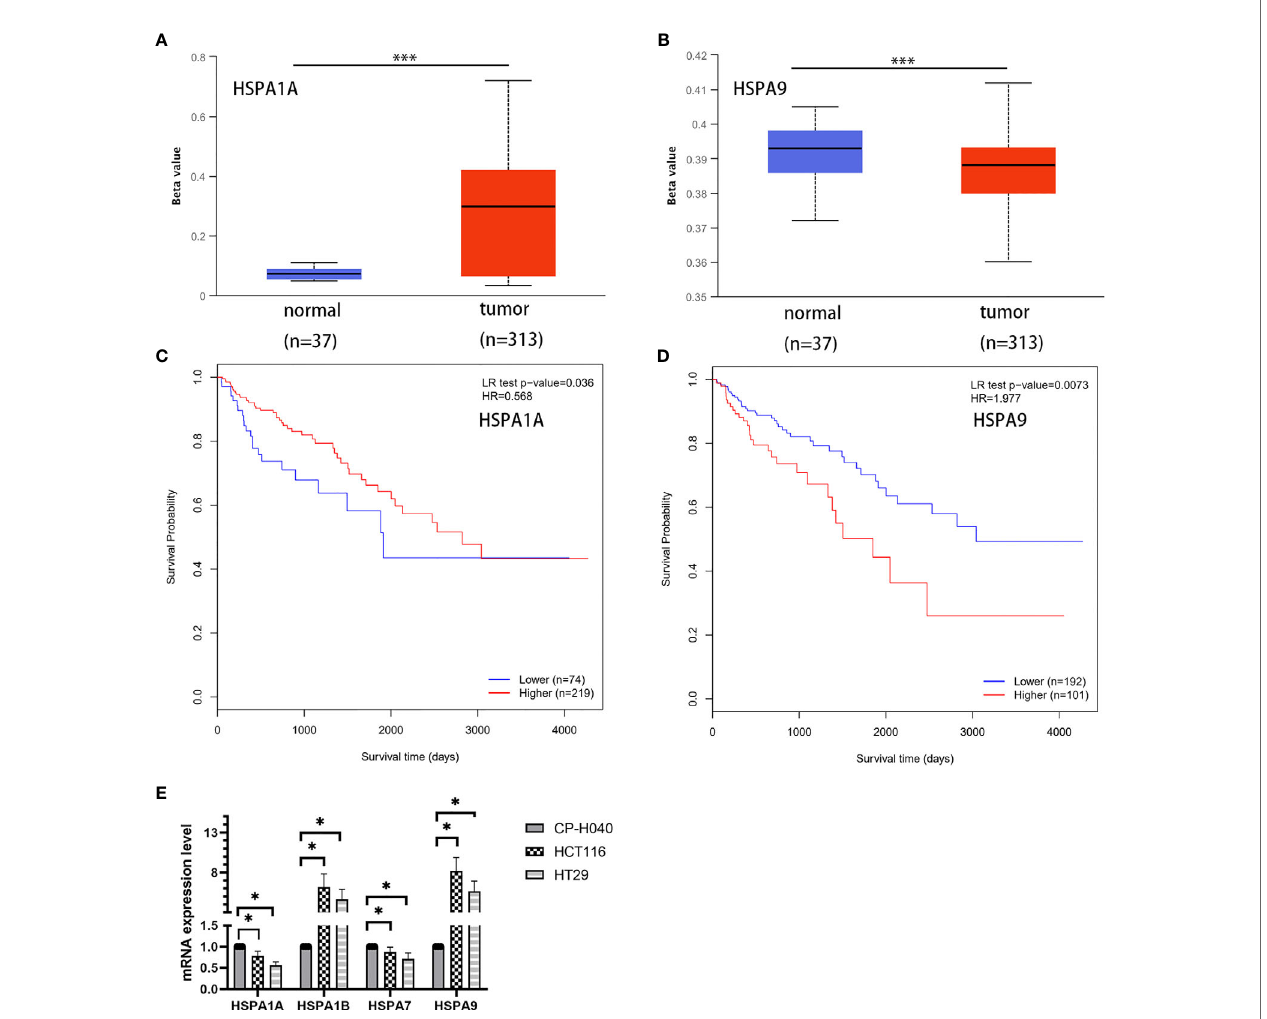
FIGURE 5 | Analysis of DNA methylation of HSPA1A and HSPA9 genes in normal and colon cancer tissues and the correlation with survival. (A) Methylation of HSPA1A promoter in colon cancer tissues and normal tissues. (B) Methylation of HSPA9 promoter in colon cancer tissues and normal tissues (*** P < 0.001). (C) Survival of patients with high and low HSPA1A promoter methylation level. (D) Survival of patients with high and low HSPA9 promoter methylation level. (E) Expression of HSPA1A/HSPA1B/ HSPA7/HSPA9 mRNA in colon cancer cells (HCT116 and HT29) and colonic epithelial cells (CP-H040) (data were presented as mean ± SD; * P <